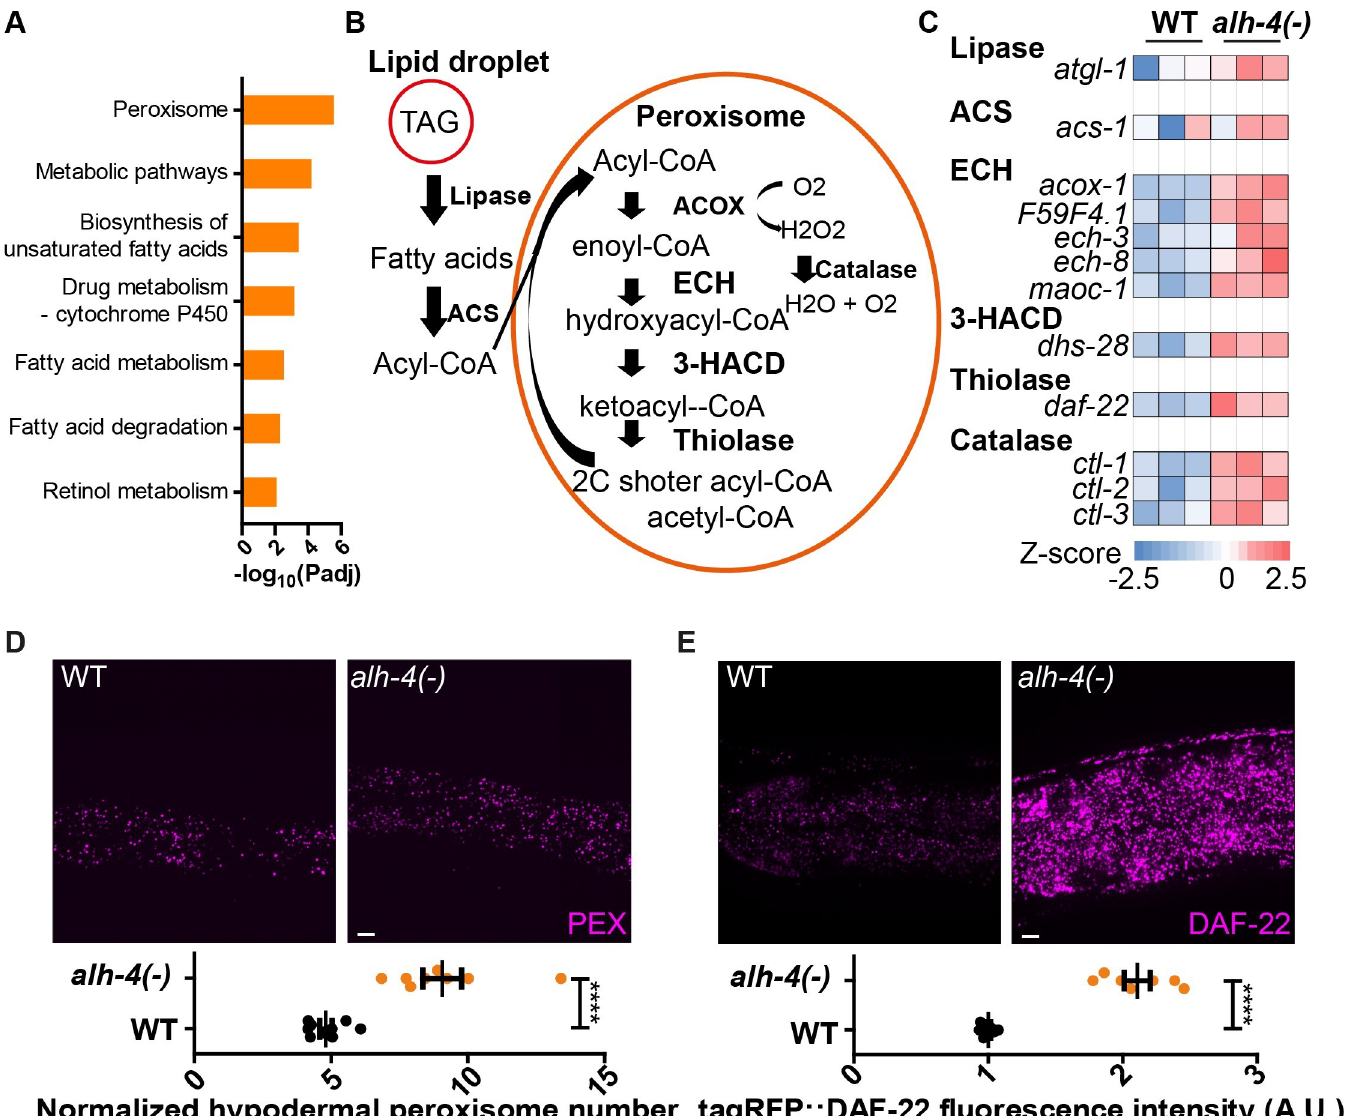
Fig 4. Induction of peroxisomal fatty acid catabolism in alh-4 mutants. (A) KEGG pathway analysis of the differentially expressed genes (fold change > 2 and p- value < 0.05, negative binomial test) between wild type (WT) and alh-4(-) worms. The analysis was performed with https://biit.cs.ut.ee/gprofiler/gost. The peroxisome pathway and additional pathways related to lipid metabolism were returned as top hits. (B) Schematic representation of the peroxisomal fatty acid β -oxidation pathway. At the top left corner, triacylglycerols (TAG) in the lipid droplet are hydrolyzed into free fatty acids by lipases. The fatty acids are converted to fatty acyl-CoA by acyl-CoA synthetases. Acyl-CoA oxidases pass electron directly to oxygen and produce hydrogen peroxide (H 2 O 2 ) while introducing the double bond to fatty acyl-CoA. Hydrogen peroxide is converted to oxygen and water via catalases. ACS, acyl-CoA synthetase; ACOX, acyl-CoA oxidase; ECH, enoyl-CoA hydratase; HACD, hydroxyalkyl-CoA dehydrogenase. (C) Heatmap showing the differential expression of genes encoding peroxisomal fatty acid β -oxidation enzymes in WT and alh-4 worms. The FPKM values are converted to Z-scores. High expression is indicated with red, while low expression is indicated with blue. n = 3 for each group. Only genes showing significant difference (p-value < 0.1) in the expression are shown except acs-1 (p-value = 0.30). (D) Representative images of hypodermal peroxisomes labeled by tagRFP::PTS1 ( hjSi486 ) in WT and alh-4(-) worms (top). Quantification of hypodermal peroxisome number (bottom). (E) Representative images showing the fluorescence signal of DAF-22 tagged with tagRFP ( hj234 ) in WT and alh-4(-) worms (top). Quantification of fluorescence signals (bottom). PEX, peroxisome; LD, lipid droplet. Scale bar = 5 μ m. In all plots, mean ± SEM of each group is shown. For all statistical test, � p < 0.05, �� p < 0.01, ��� p < 0.001, ���� p < 0.0001, the actual p-value is displayed when p is between 0.05 and 0.1, n.s. (not significant) p > 0.1 (two-tailed unpaired Student’s t-test).